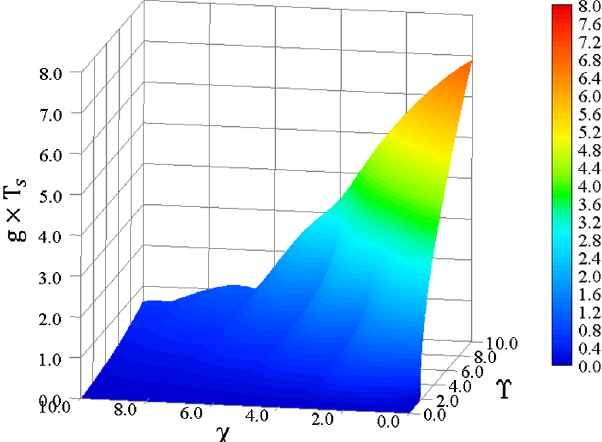
FIG. 17. The three-dimensional contour plot of the growth factor g × T as a function of ϒ and χ for TFCT ¼ 4 at the rms s bunch length of 2 cm in the trapezoidal wake model for the Vlasov analysis with the Gaussian bunch distribution.